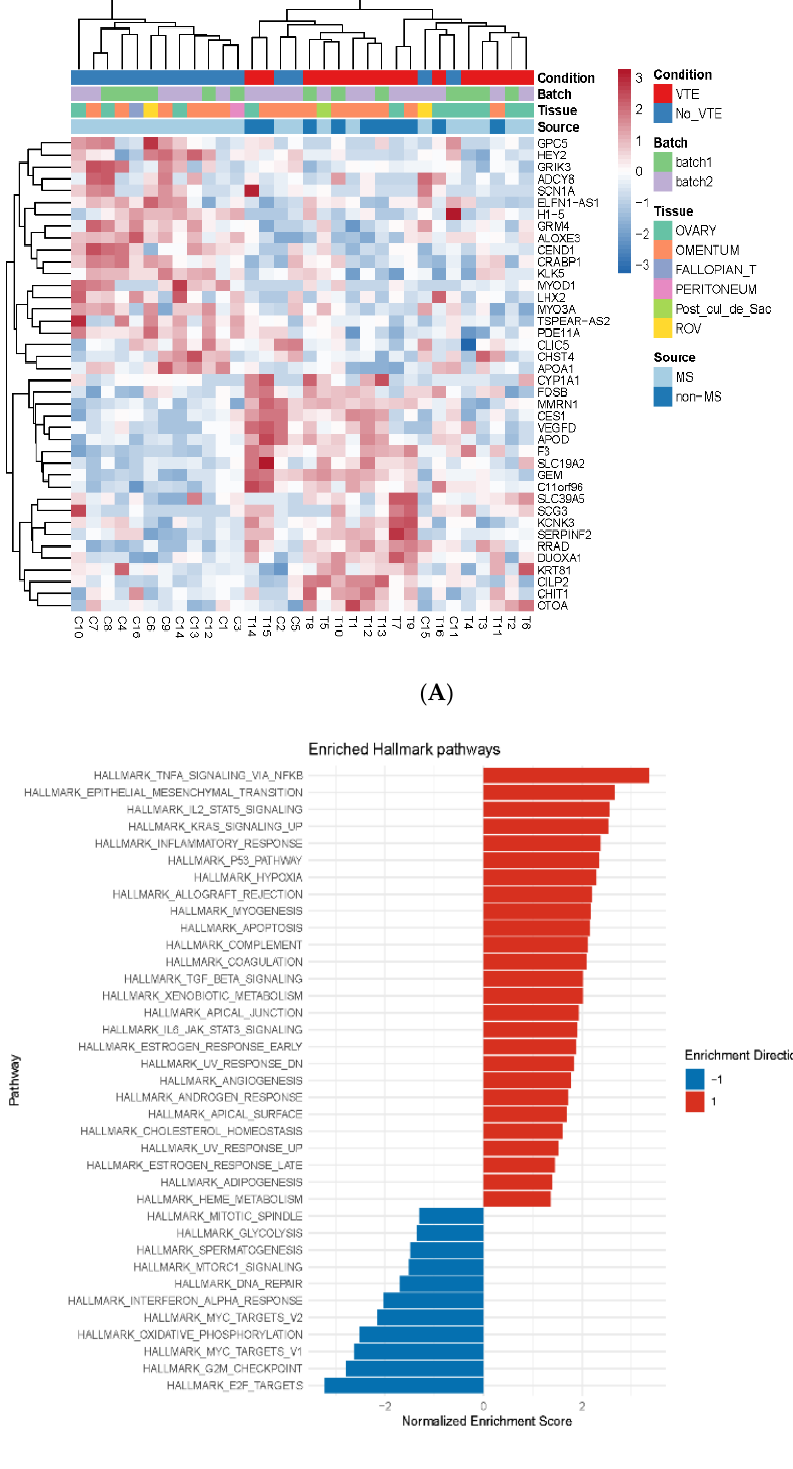
Figure 2. Differentially expressed genes and metabolic pathways in HGSC patients in VTE and control groups. ( A ) Heat map of the top 40 altered transcripts in HGSC tumor tissue in patients with and without venous thromboembolism (VTE). Abbreviations: Fallopian_T, fallopian tube; Post_cul_de_sac, posterior cul de sac; ROV, right ovary; MS, moonshot cancer database; non-MS, non-moonshot cancer database. ( B ) Gene set enrichment analysis (GSEA) identifying enriched pathways for VTE compared to non-VTE controls. Red indicates enhanced enrichment; blue indicates decreased